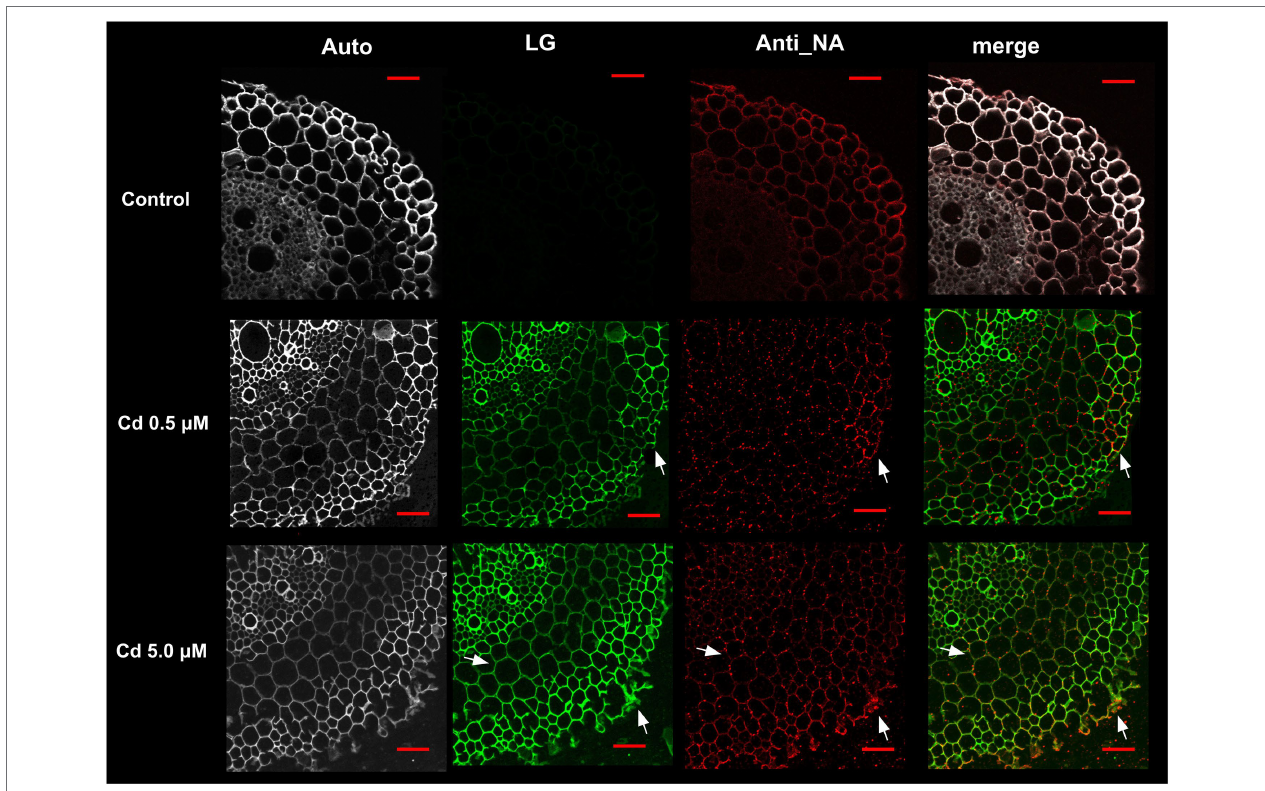
FIGURE 8 | Immuno-localization of nicotianamine (NA) in roots of wheat plants grown for 15 days (starting from sprouting) in control conditions and with Cd 0.5 μ M and 5.0 μ M; Auto: root tissues autofluorescence; LG: root cross-sections stained with Leadmium Green AM; Anti_NA: root cross-sections labeled with antibodies directed against NA/fluorescent secondary antibodies; merge: images of green (LG) and red (Anti_NA) channels merged; white arrows indicated points of the red and green pixels colocalization. Scale bars = 50 μ